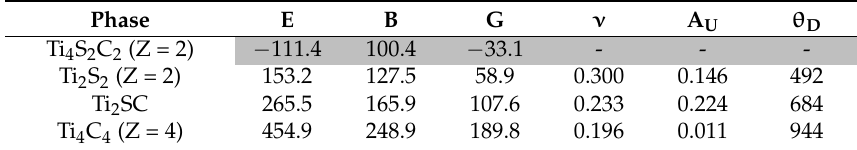
Table 3. Calculated Young’s modulus E (GPa), bulk modulus B (GPa), shear modulus G (GPa), Poisson’s ratio ( ν ), universal anisotropy index (A U ), and Debye temperature ( θ D in K) of the